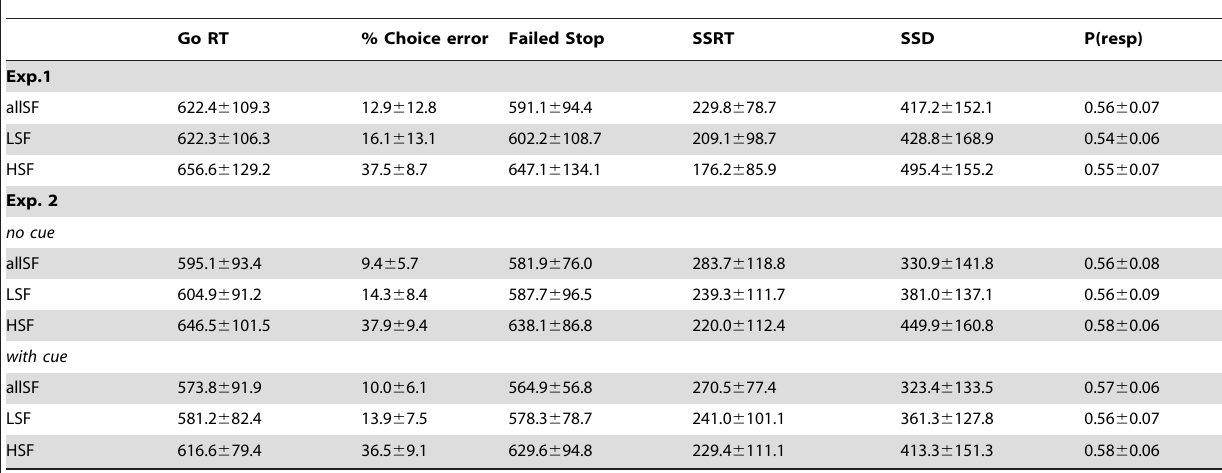
Table 1. Behavioral overview of all visual stop task